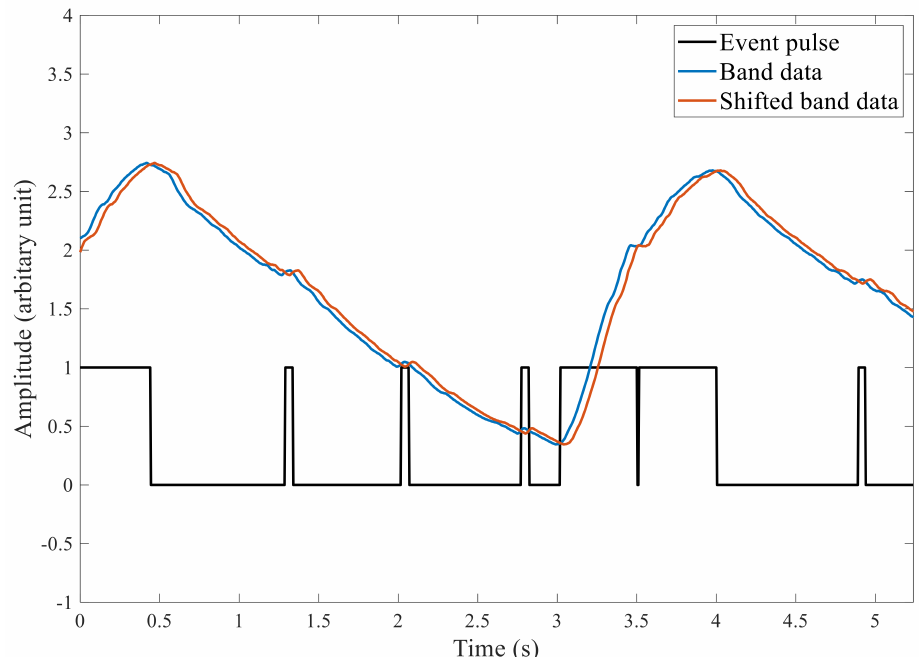
Figure 6. The output of the event generation step showing the original band signal ( Y ( n ) ), shifted band signal ( Y ( n + p ) ), and the event signal ( V ( n ) ) represented as binary values. Inverted event pulse during the inspiration (at 3.5s